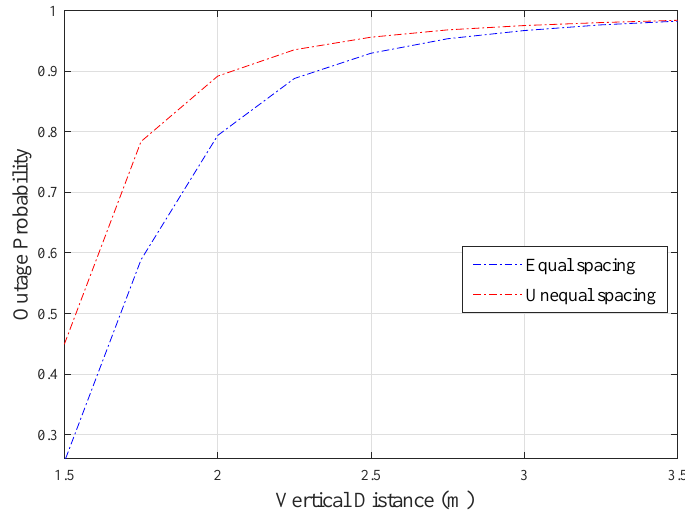
Figure 6. Simulated results of DF relay with N =